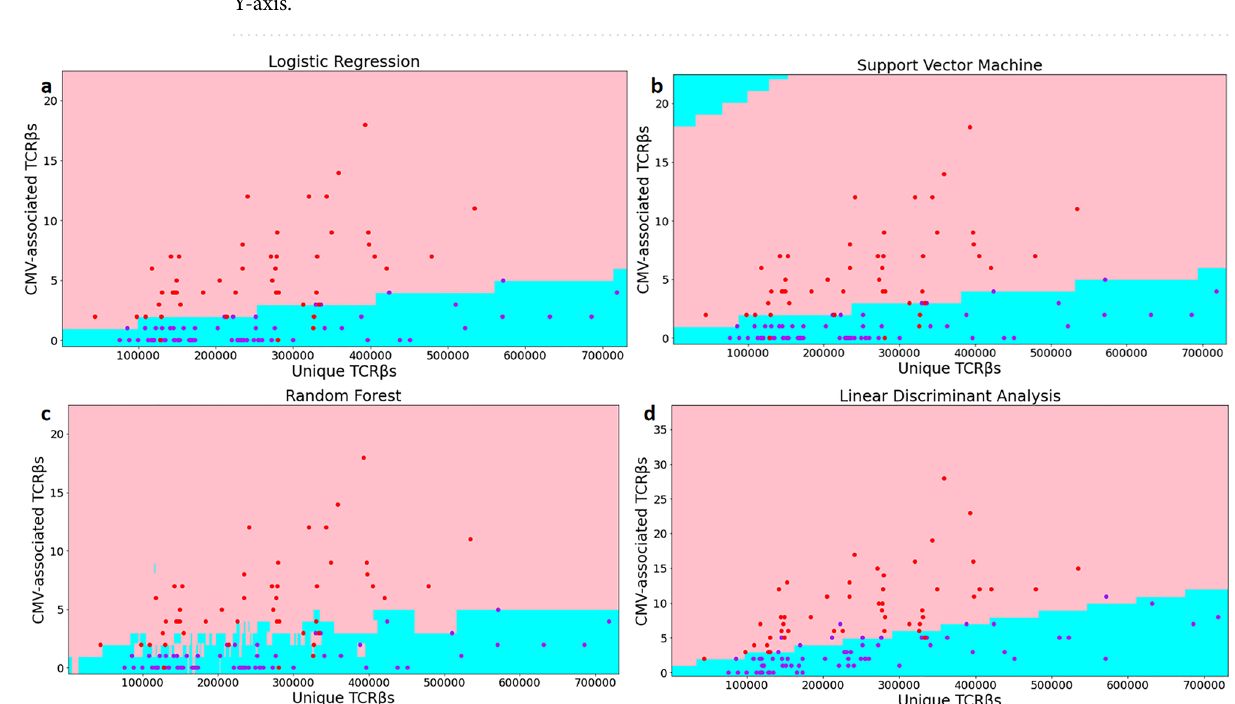
Figure 3. Scatter plots and area classification lines of testing samples. The figure depicts a scatter plot of positive and negative decision boundaries obtained by the four classification algorithms trained on cohort1 training samples and cohort2 test samples, where the x-axis represents the total number of TCRβ sequence species per sample and the y-axis donates the number of repeat species with associated TCR sequences. The blue dots represent negative samples in cohort 2, and the red dots represent positive samples in cohort 2. The pink and sky blue regions represent the positive and negative regions obtained by training each algorithm’s cohort1 training data, respectively. Figure ( a – d ) shows the classification graph algorithms and the distribution of test sample points of the LR, SVM, RF and LDA,